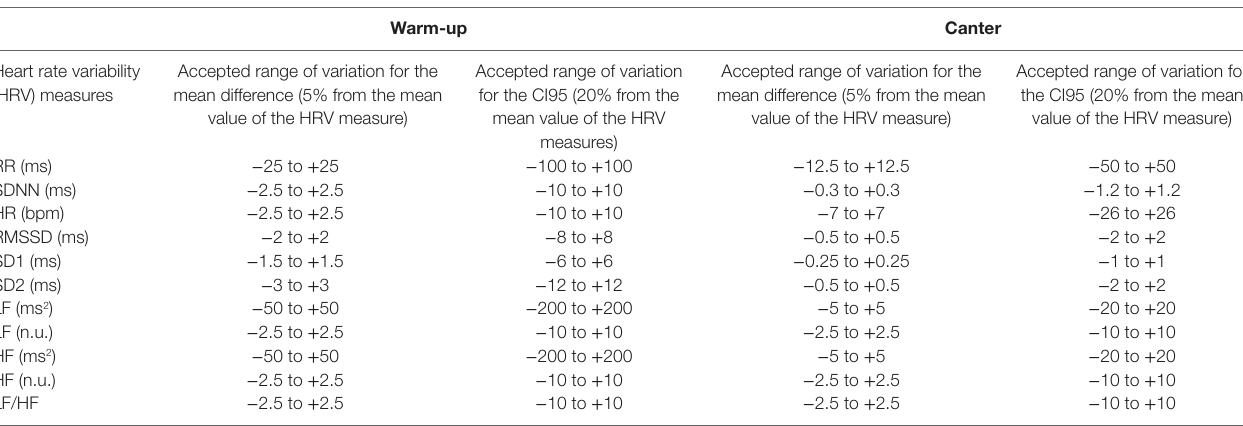
TaBle 1 | Agreement limits for the Bland–Altman analysis.